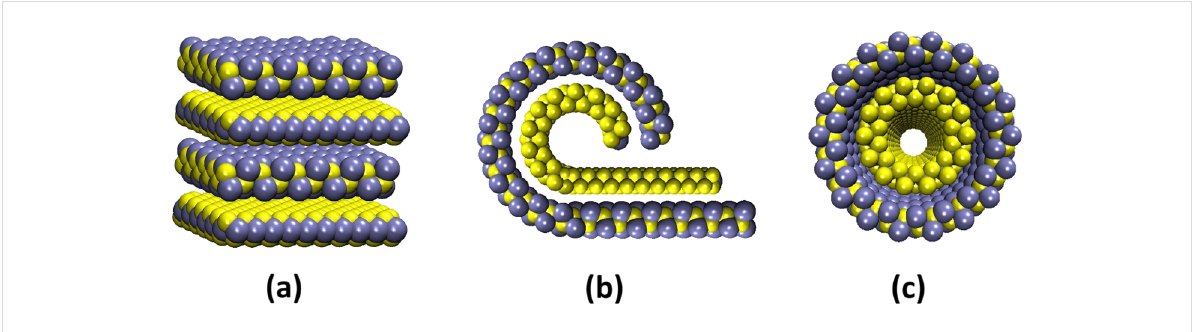
Figure 6: SnS–SnS 2 misfit compounds forming nanoscrolls and nanotubes. Yellow spheres represent sulfur atoms and blue spheres tin atoms.